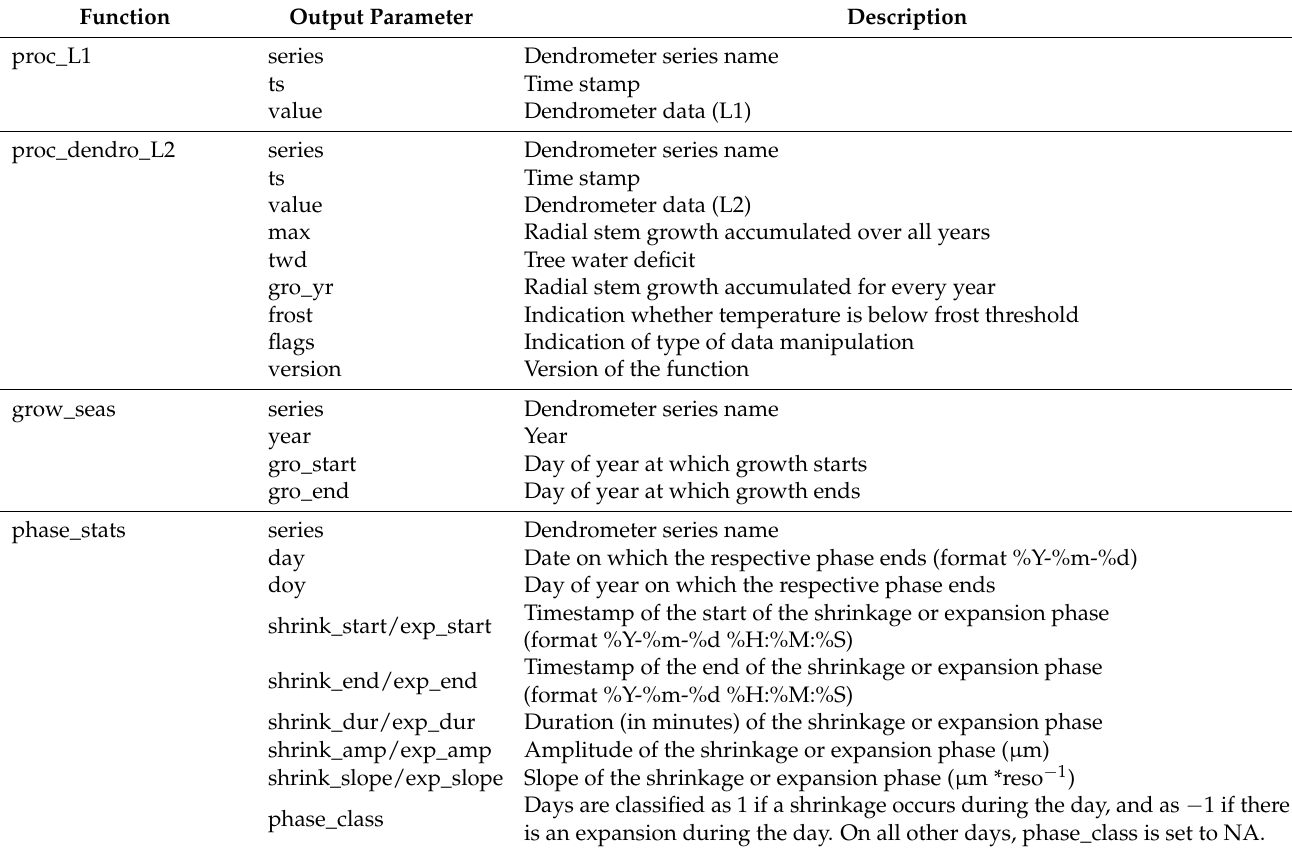
Table 1. Output variables of functions of